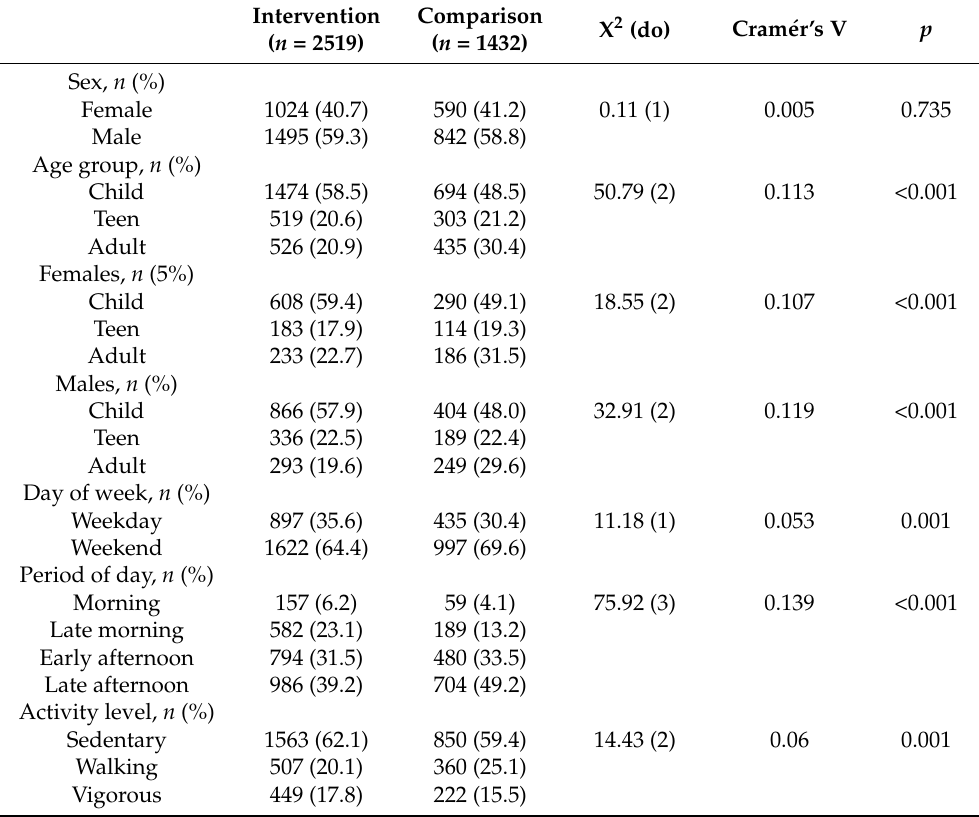
Table 3. Associations in observed park and user characteristics between intervention and comparison parks.